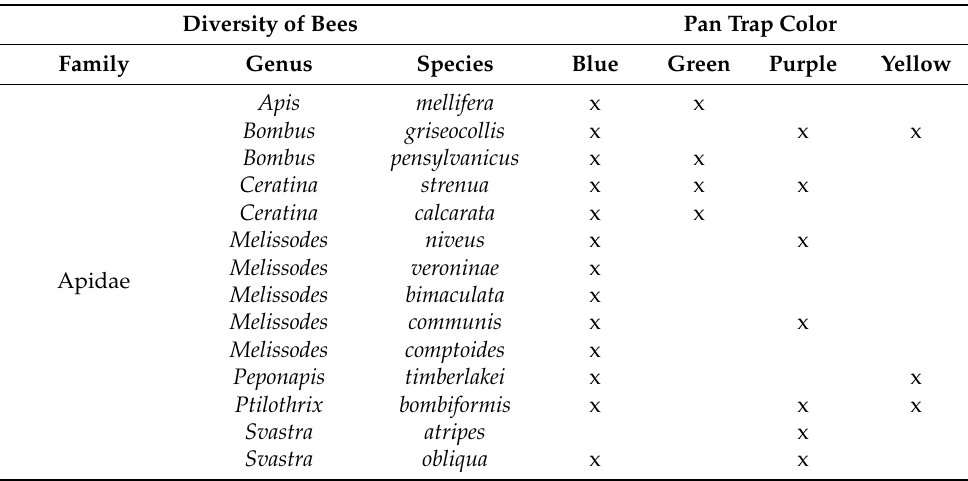
Figure 3. Rarefaction curve showing accumulation of the number of species in relation of the number of samples ( A ) and number of individuals ( B ). Dotted line in ( B ) indicates at what abundance value interpolated richness values were compared. Different superscript letters indicate significant differences among trap colors. Table 1. Bee species diversity (family, genus, and species) collected using different color pan traps (blue, green, purple, and yellow) in Arkansas livestock pasture ecosystem in 2018.